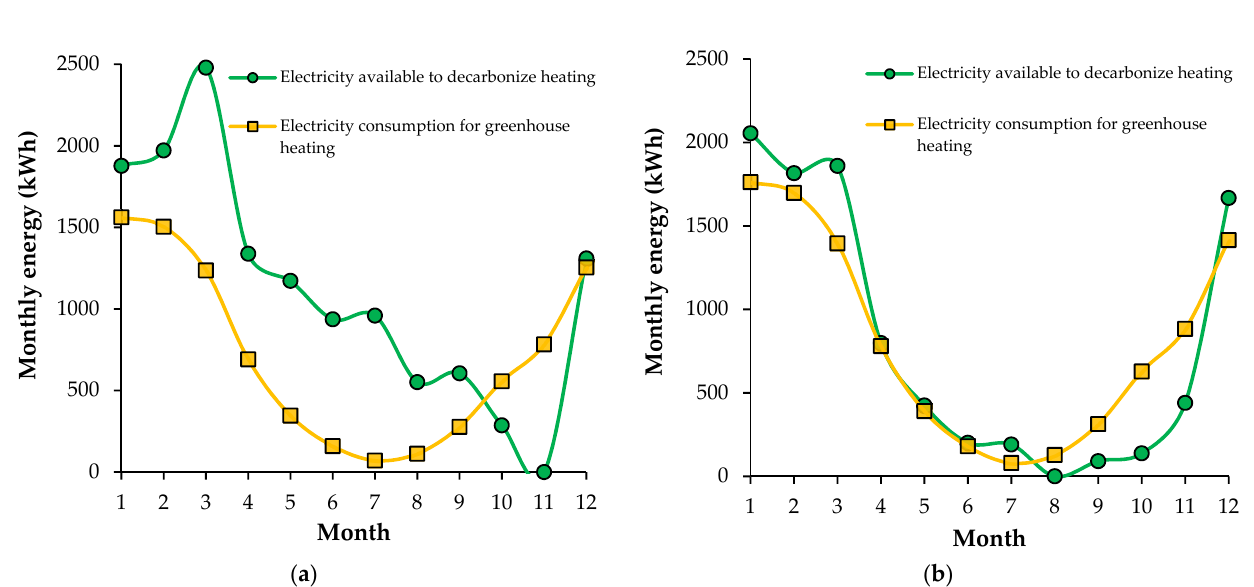
Figure 7. Monthly electricity available to decarbonize heating compared to the electricity consumption of the greenhouse (based on the area determined in Table 5) for: ( a ) a retrofitted house; ( b ) a rebuilt house.